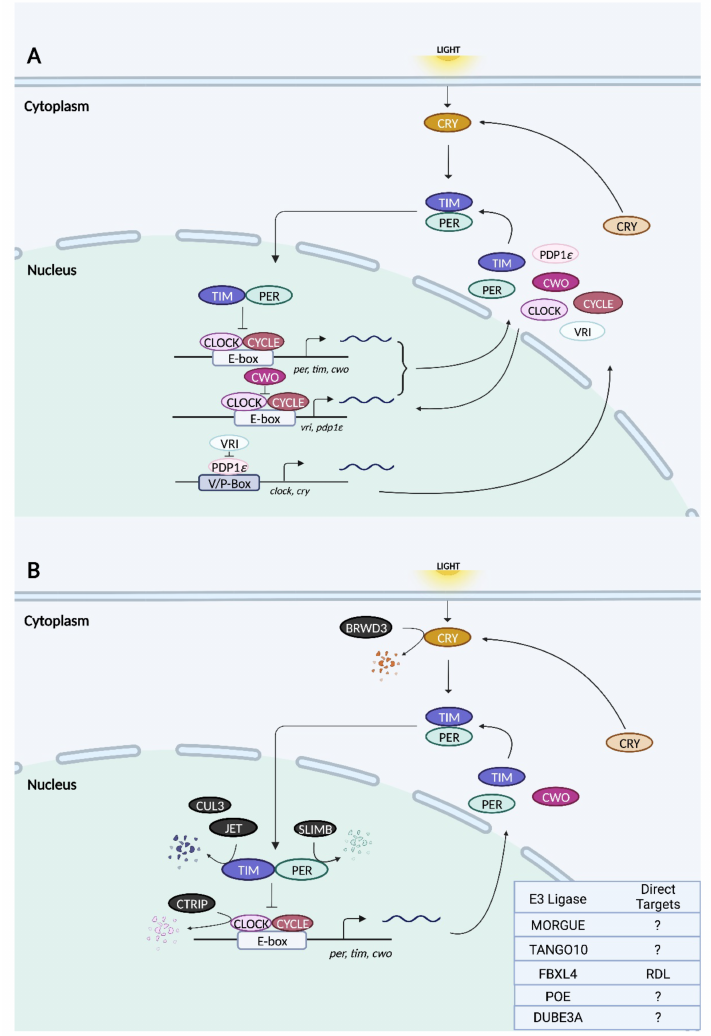
Figure 3. Schematic of circadian transcription–translation feedback loops (TTFLs) ( A ) and the rela- tionships of known E3 ligases to core clock proteins in Drosophila ( B ). ( A ) In the primary TTFL of flies, transcription factors CLOCK and CYCLE heterodimerize and trigger E-box-mediated transactivation of target genes including per, tim, vri, pdp1 ε , and cwo. Once translated, PER and TIM heterodimerize and accumulate in the cytoplasm. Following their translocation to the nucleus, PER:TIM com- plexes repress their own E-box-mediated transcription through association with CLOCK:CYCLE. In a secondary TTFL, the proteins VRI and PDP1 ε exhibit opposing functions, where the former inhibits clock transcription at the V/P box region, while the latter activates it. Lastly, CWO competes with CLOCK:CYCLE for E-box binding, thereby repressing transcription in yet another feedback loop. Drosophila CRY is a photoreceptor that aids in TIM degradation upon light activation. ( B ) All Drosophila E3 ubiquitin ligases that have been demonstrated to target a core clock protein for degrada- tion are indicated in black. E3 ligases whose targets are either unknown or not core clock proteins are indicated in the chart in the bottom right corner. The site of action (nucleus vs. cytoplasm) for all E3 ligases is not known. In the figure, the localization of each E3 ligase is for illustrative purposes only. Additional feedback loops exist to fine-tune the pacemaking of the primary TTFL. One such loop regulates the rhythmic transcription of clock with a pair of opposing bZIP transcription factors: PDP1 ε activates clk transcription, whereas VRILLE inhibits it